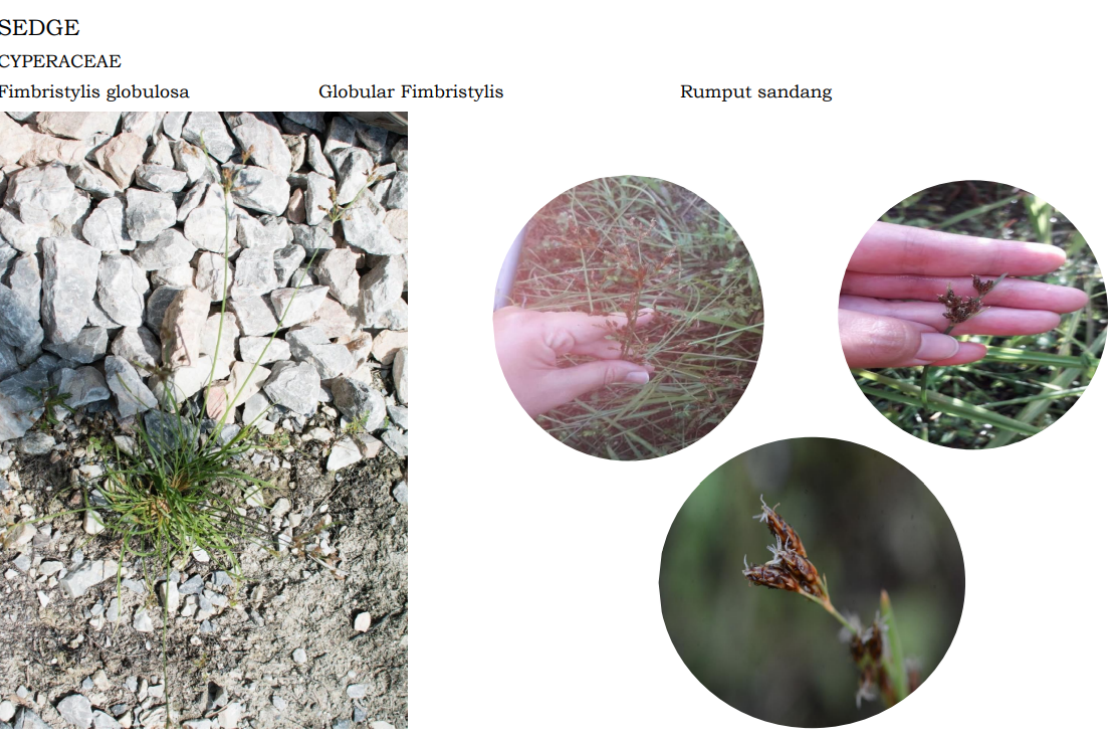
Figure A7. Sedge Cyperaceae: Fimbristylis globulosa.